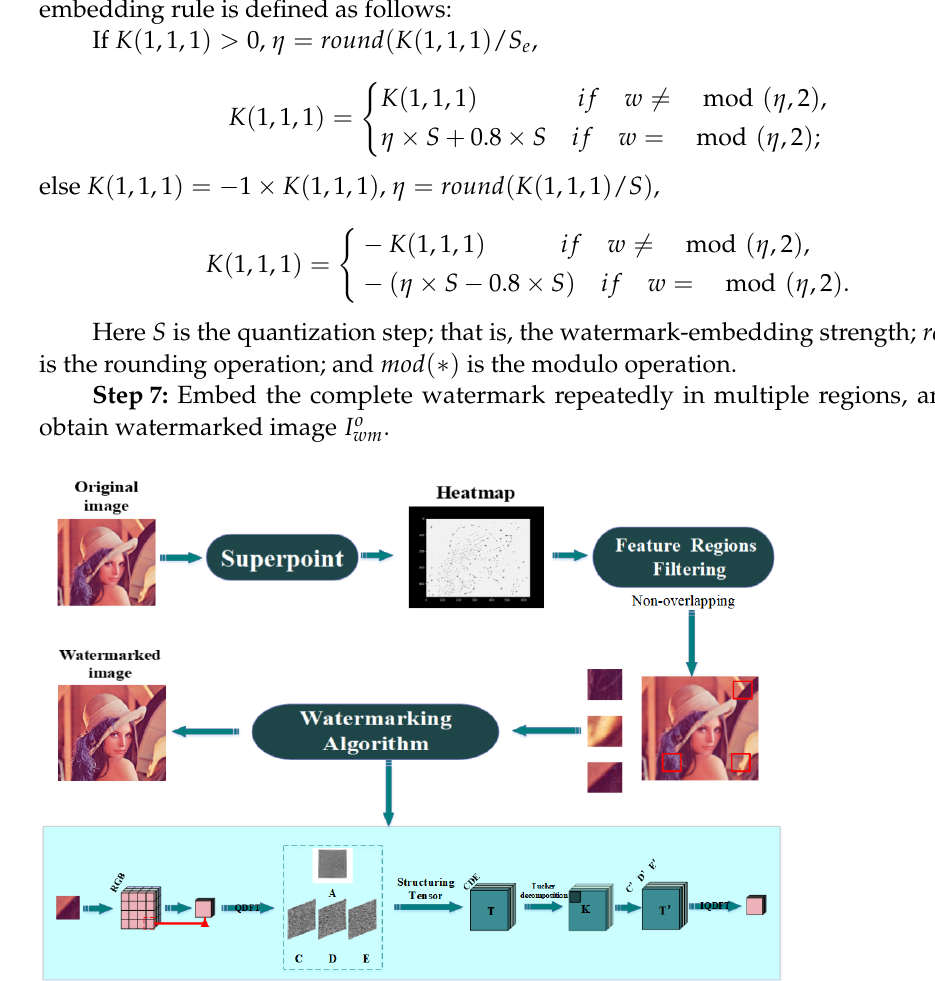
Figure 4. The architecture of the proposed scheme embedding